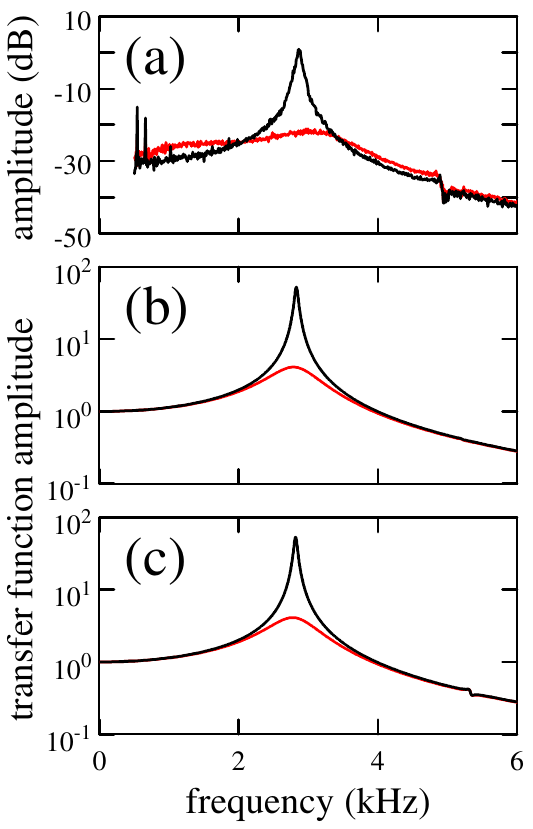
FIG. 1. (Color) Operation with passive harmonic-cavity voltage equaling 22% of that required for optimal bunch lengthening. Black curves: phase feedback off. Red curves: phase feedback on. (a) Experimental measurement of the transfer function amplitude. (b) Transfer function amplitude calculated with the beam energy spread equaling its natural value. (c) Transfer function amplitude calculated with the beam energy spread equaling 3 times its natural